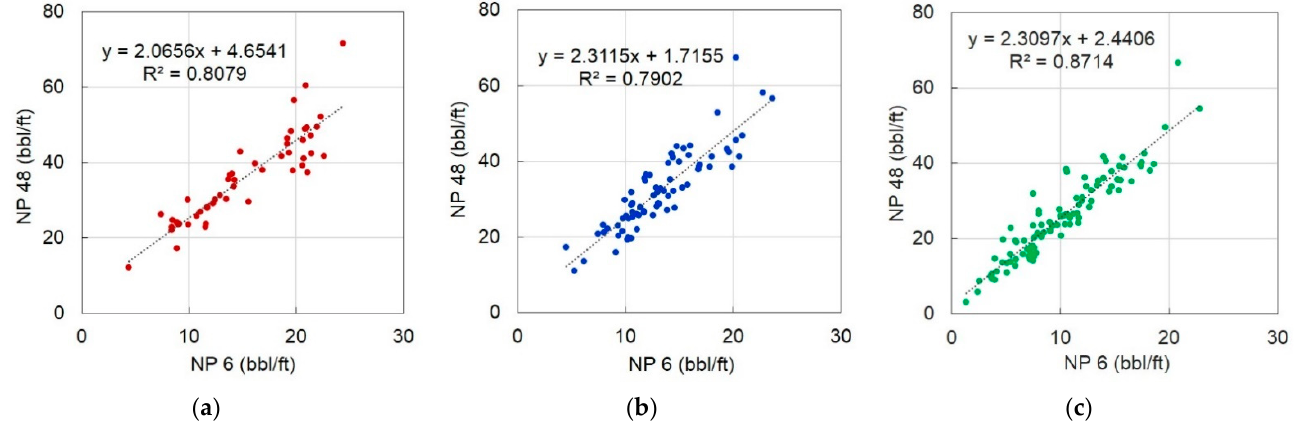
Figure 15. Relationship between NP 6 and NP 48 by group: ( a ) Cluster 1; ( b ) Cluster 2; ( c ) Cluster 3.